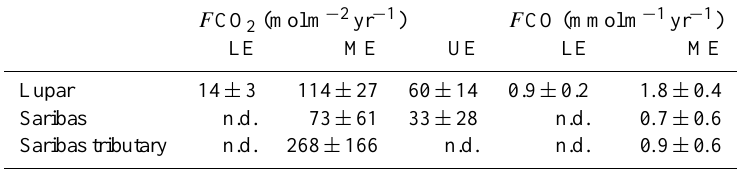
Table 3. CO 2 and CO fluxes in the Lupar and Saribas estuaries determined with a floating chamber.